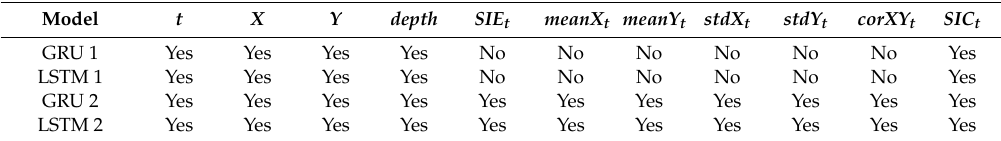
Table 3. Data schemes in GRU 1, GRU 2, LSTM 1, and LSTM 2.